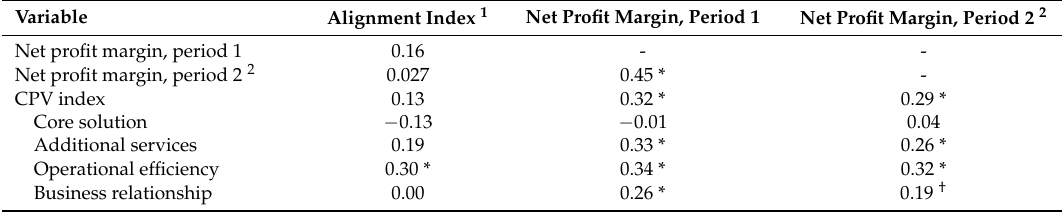
Table 7. Pearson’s correlations between the numerical variables in the